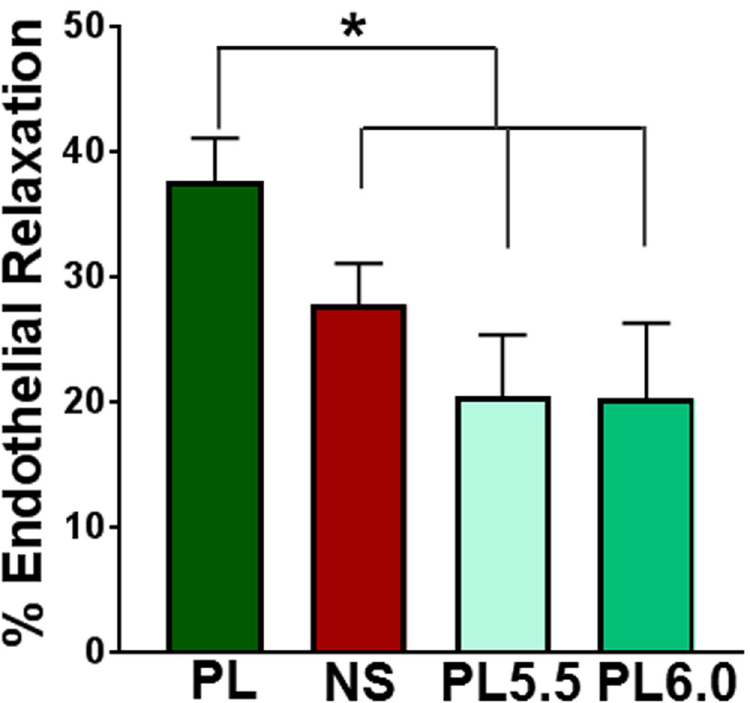
Fig 5. Incubation in Normal Saline (NS) or Plasma-Lyte (PL) rendered acidic leads to decreased endothelial dependent relaxation in intact na ï ve porcine saphenous veins (PSV). Rings of PSV were incubated in PL; NS; or PL in which the pH had been adjusted to 5.5 or 6.0 for 2 hours. The strips of PSV were then suspended in a muscle bath and pre-contracted with phenylephrine (5 x 10 − 7 M) and treated with carbachol (5 x 10 − 7 M, n = 5–7 pigs � p < 0.05).